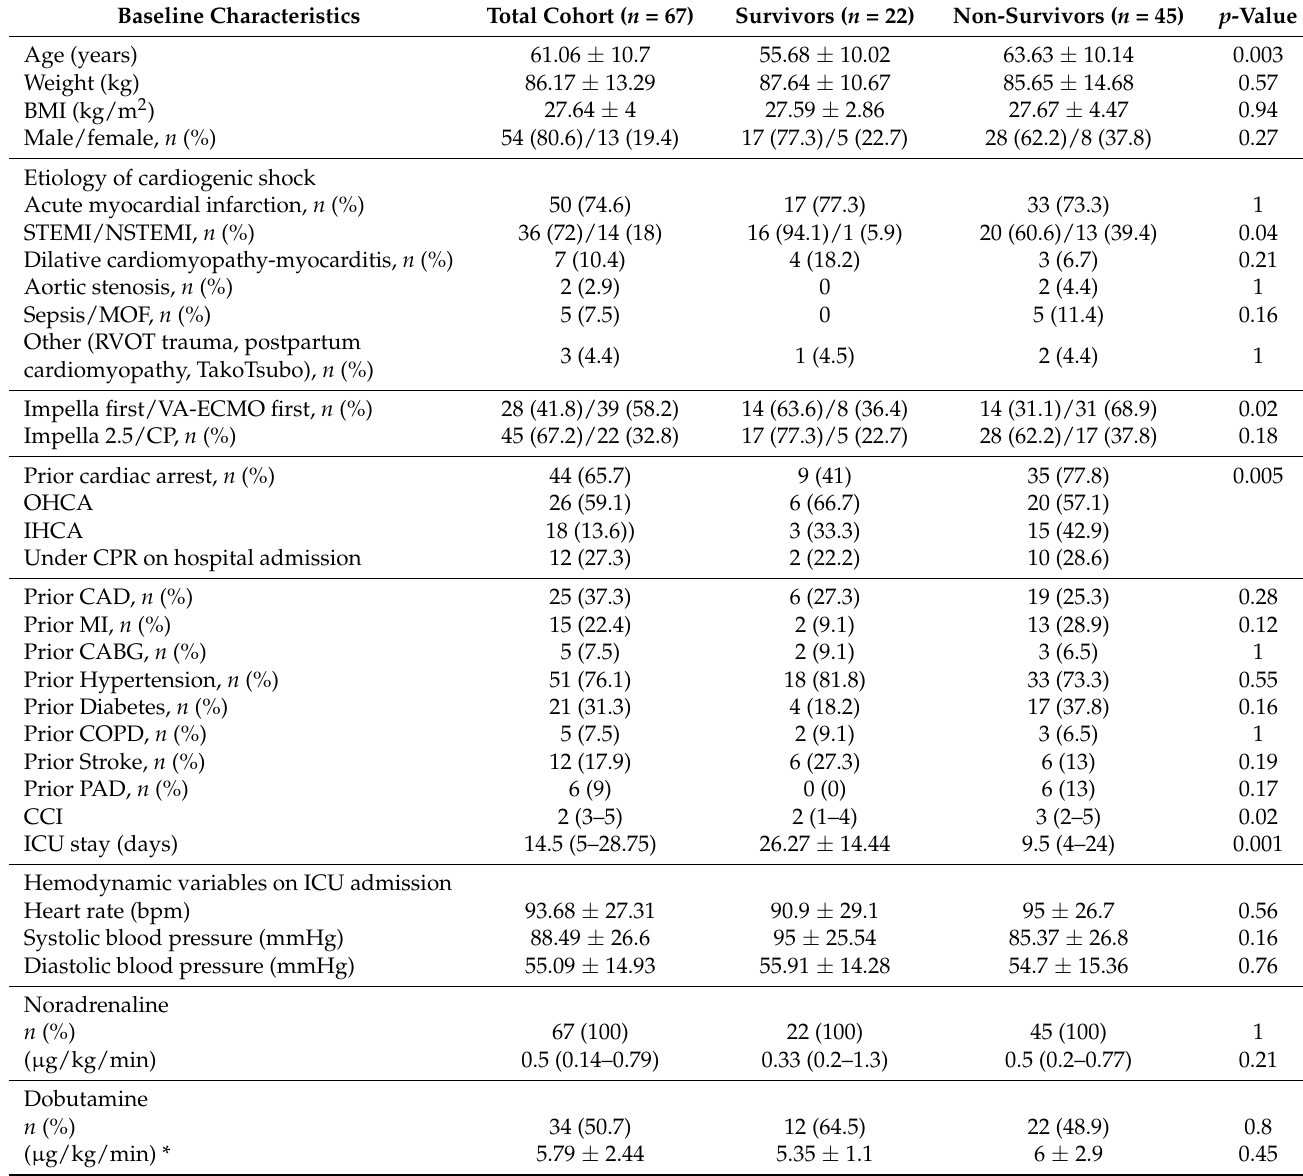
Table 1. Baseline Characteristics of the study